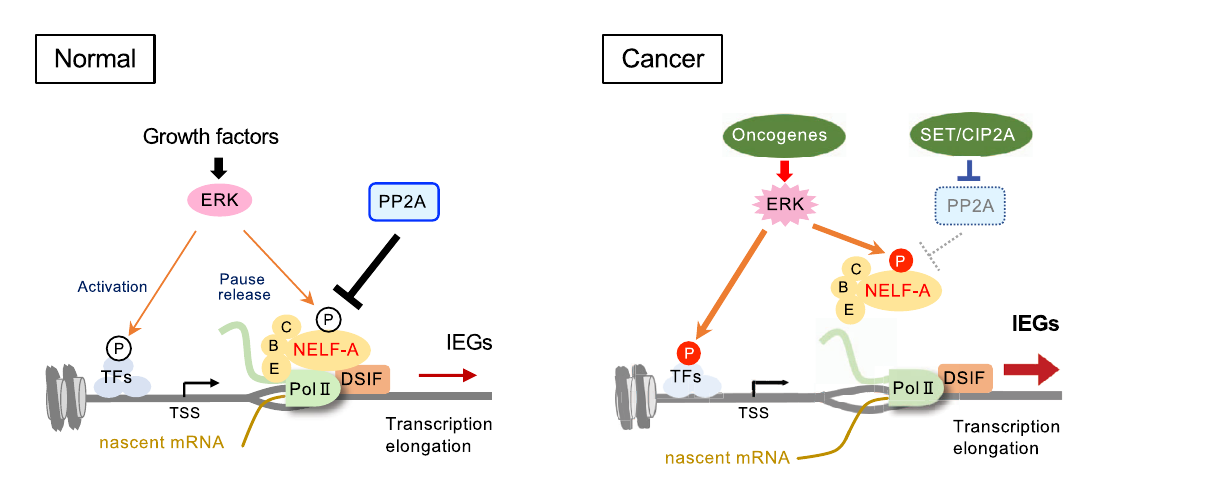
Fig. 9 | A schematic model ofERK-mediatedtranscriptionalregulationofIEGs. In normal cells (left), NELF directly binds to and stalls Pol-II near the TSSs of IEGs. Upon growth factor stimulation, activated ERK rapidly phosphorylates NELF-A, whichdissociatesNELFfrompausedPol-II,allowingPol-IItoresumeelongationand produce full-length transcripts. ERK also phosphorylates and activates TFs (e.g., ELK1), which increases the rate of the transcription cycle of Pol-II. Through